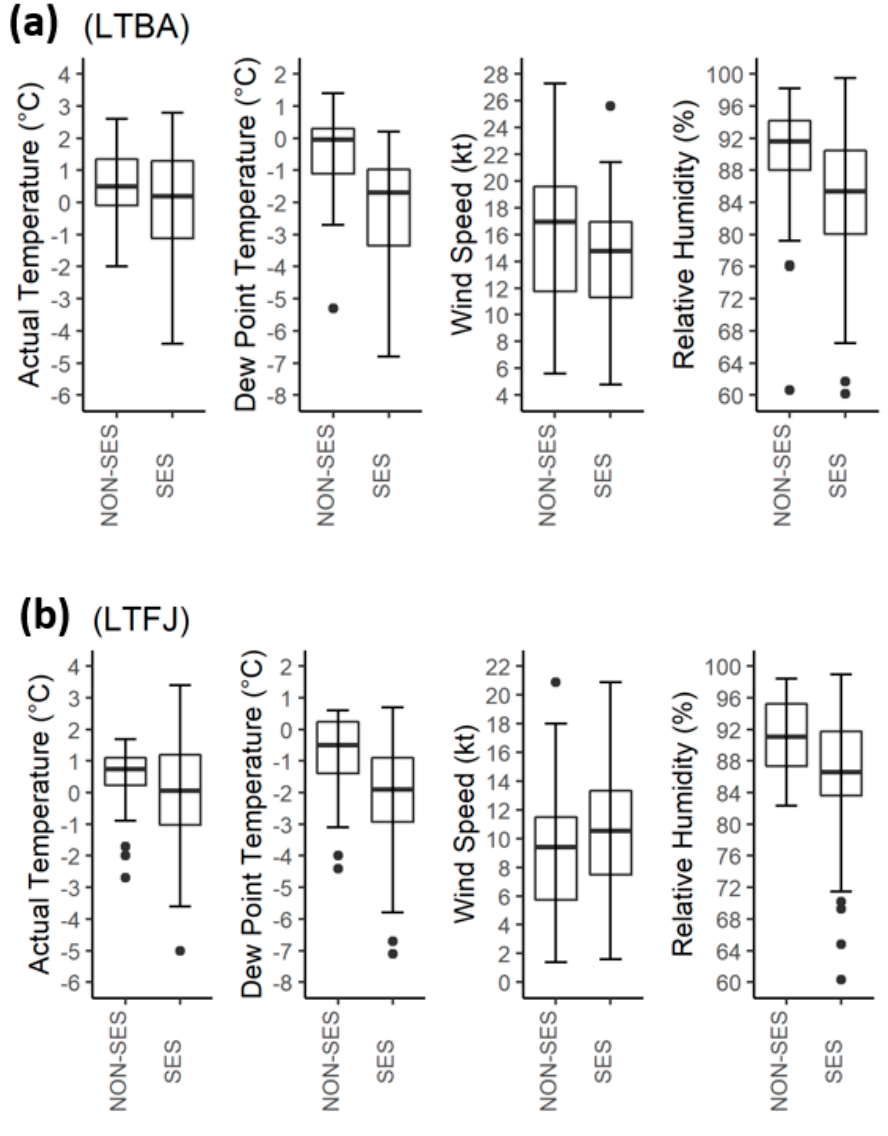
Figure 3. The comparison of meteorological parameters in SES and non-SES events at ( a ) LTBA and ( b ) LTFJ. Table 2. The wind direction frequencies in SES and non-SES events at LTBA and LTFJ. Wind